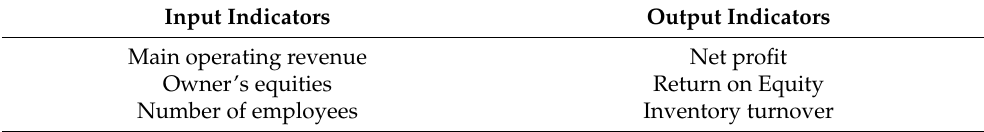
Table 2. List of input and output